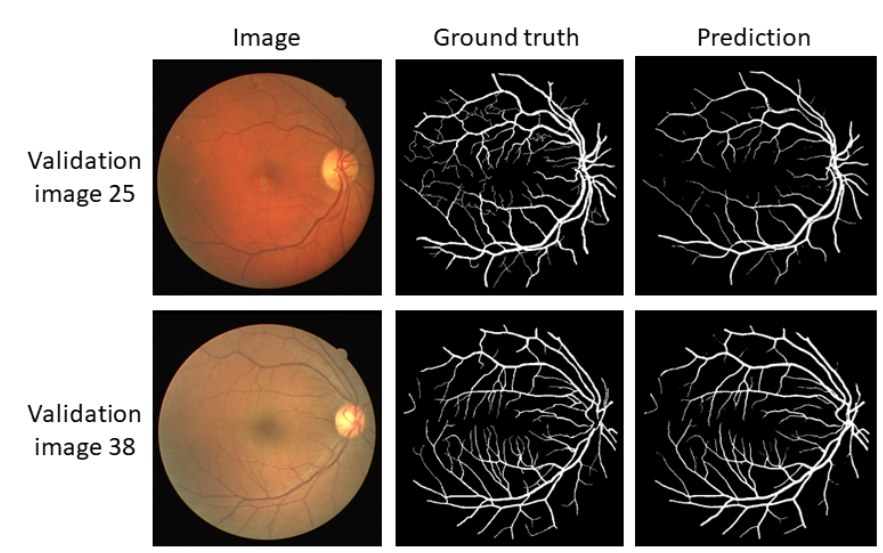
Figure 4. Two validation images, its real mask and the U-Net prediction.